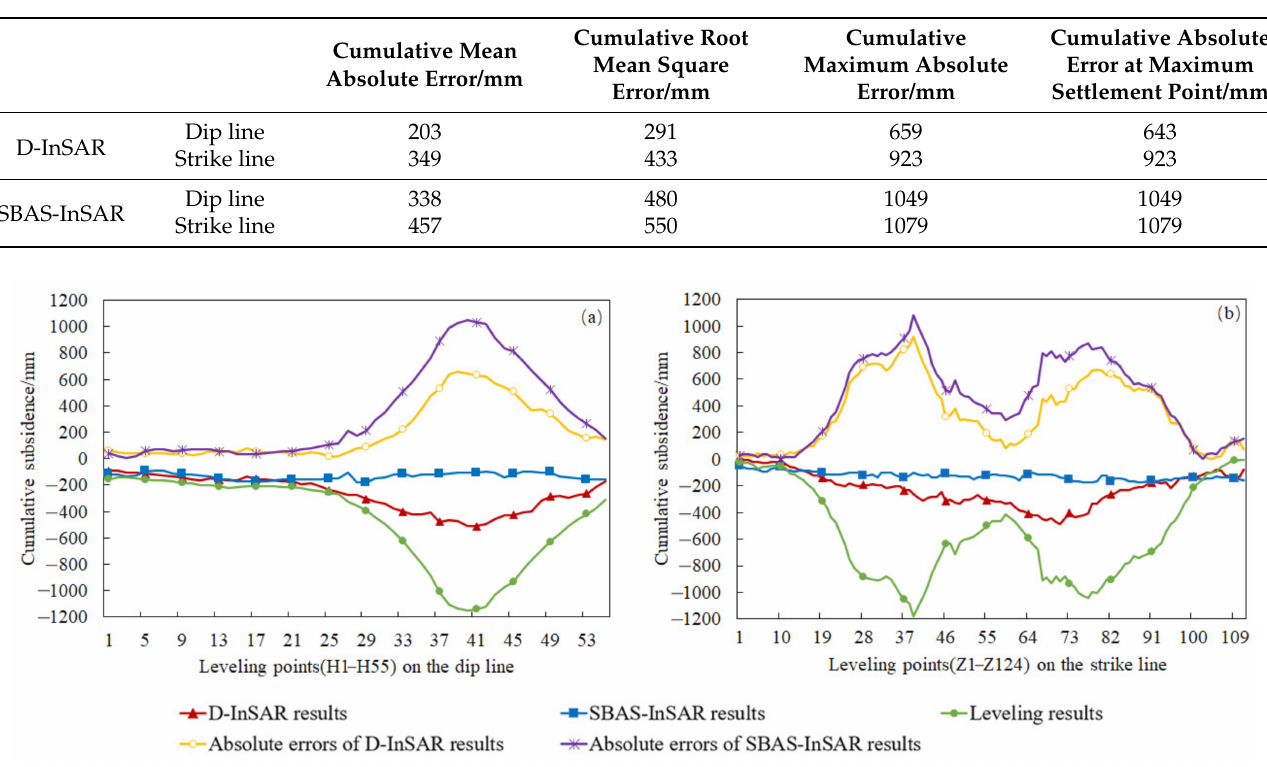
Figure 7. Comparison between InSAR- and leveling-monitored results: ( a ) dip line and ( b ) strike